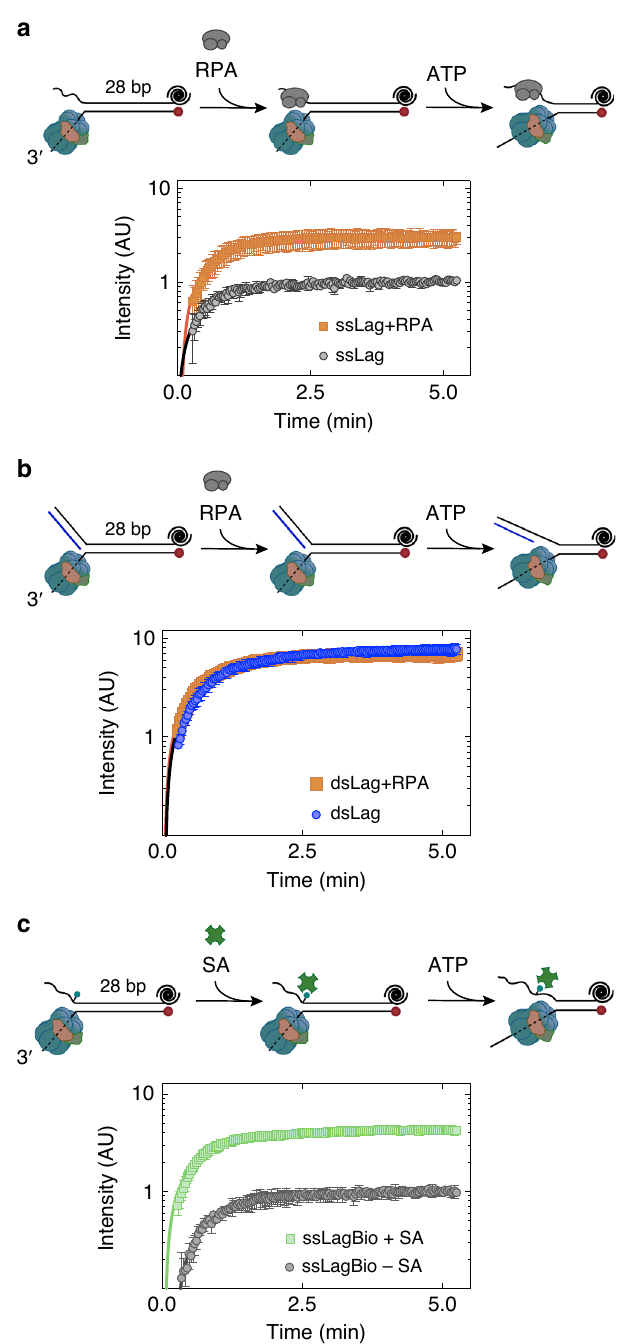
Fig. 5 Binding of a protein to the excluded strand promotes DNA unwinding by CMG. a Single-turnover time-course unwinding of Fork ssLag by CMG in the absence (black) and presence (orange) of RPA. b Single- turnover time-course unwinding of Fork dsLag by CMG in the absence (blue) and presence (orange) of RPA. a , b RPA was added after CMG binding to the fork. A competitor oligonucleotide was included with ATP addition to prevent further RPA and CMG binding during unwinding. Data represent mean ± SD ( n = 3). c CMG-catalyzed single-turnover unwinding of fork DNA containing a single biotin on the lagging-strand arm in the absence (black) and presence (green) of streptavidin (SA). Data represent mean ± SD ( n = 3 independent experiments). Solid lines are fi ts to Eq. (2) (Methods). Source data are provided as a Source Data fi